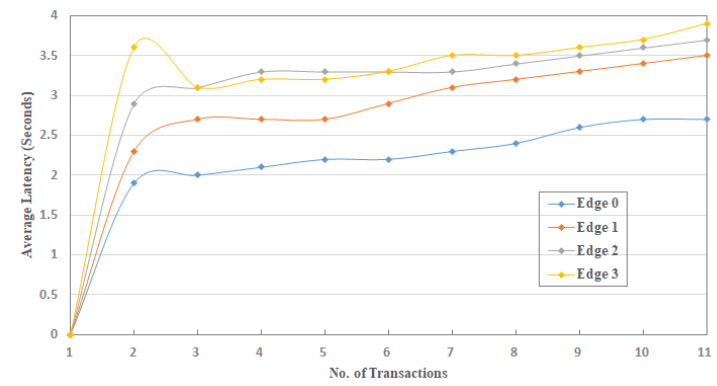
Figure 6. Average latency considering communication cases 5 and 6.